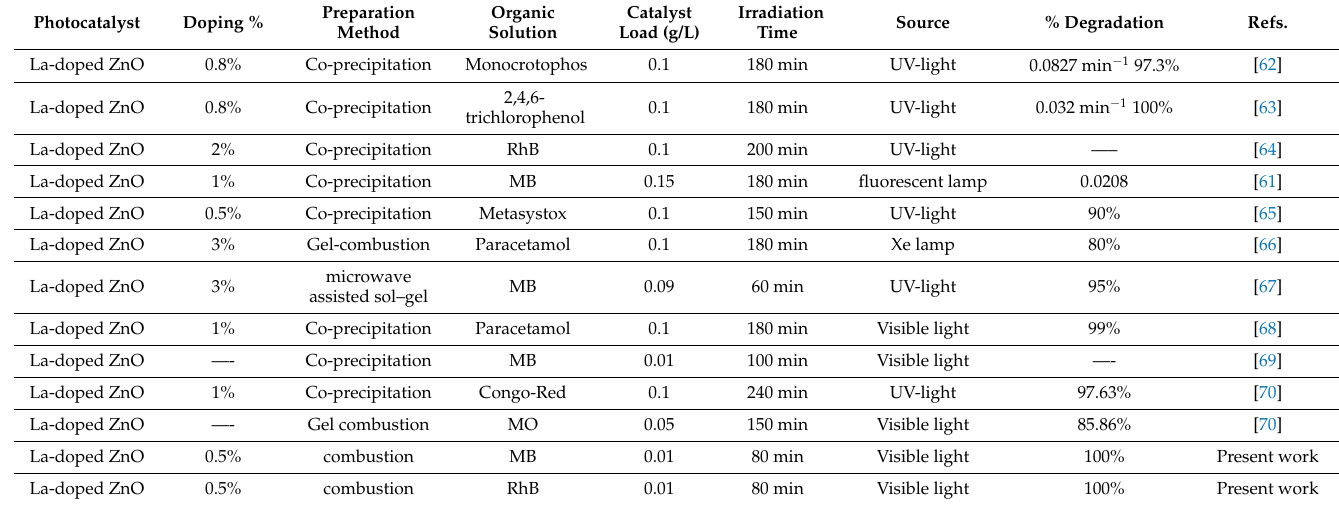
Table 5. Comparison of photocatalytic activities of some ZnO-based